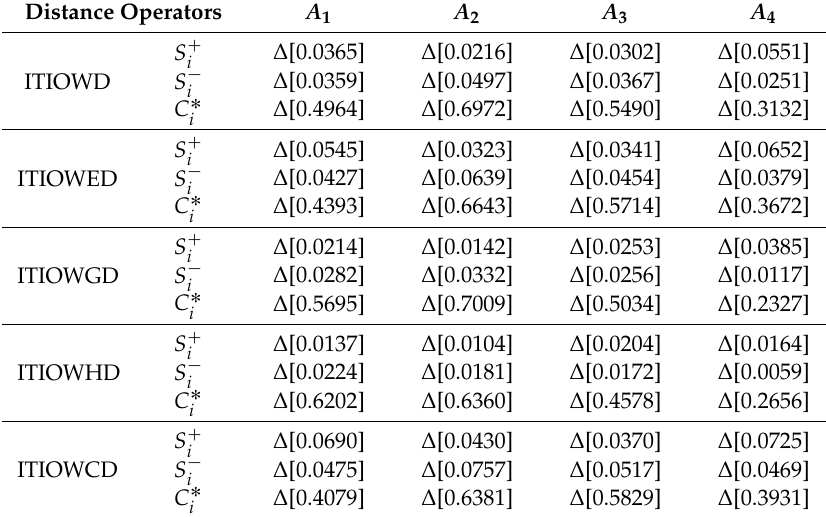
Table 7. Aggregated results